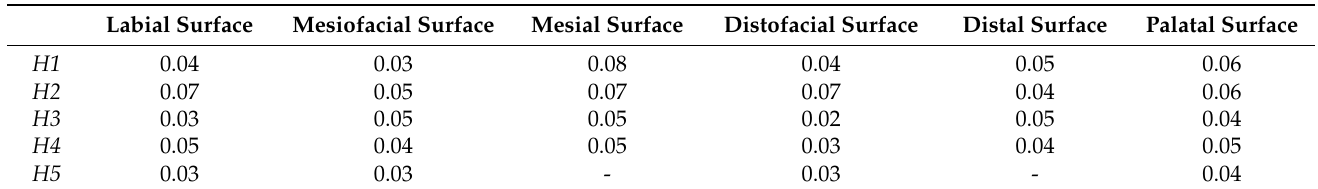
Table 2. Median of difference between e1 (measured by OCT) and e2 (measured by microscopy) for maxillary lateral incisors (mm).